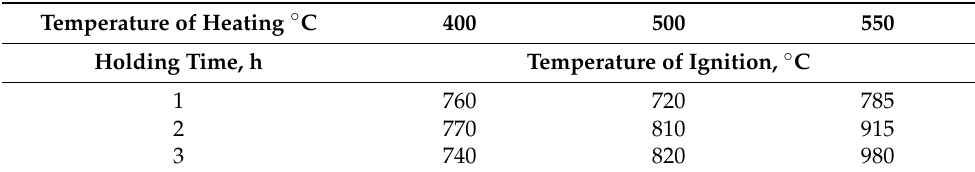
Figure 12. Thermograms of ignition of Ni – Al and Ni – Al – PTFE powder mixtures. Table 3. Temperature of ignition of Ni – Al specimens after HT.